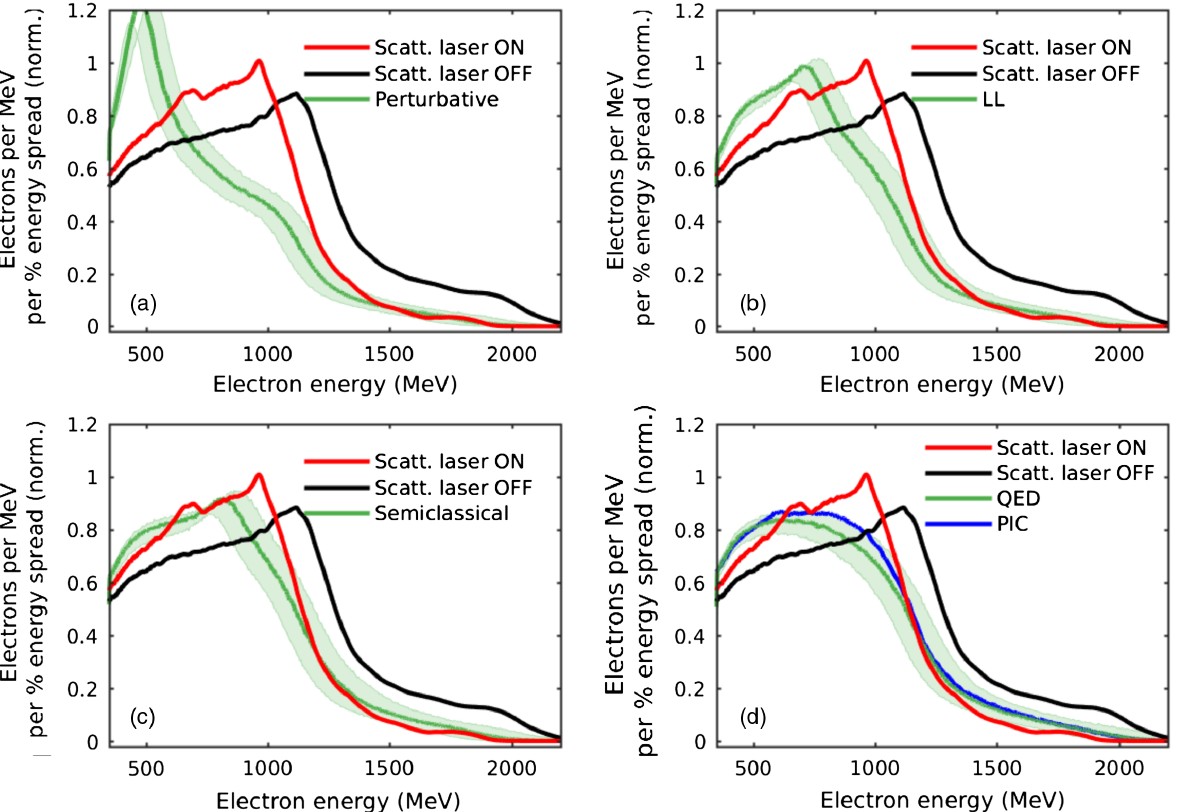
FIG. 4. Comparison of experimental results with theoretical models for the condition of best overlap. The experimentally measured electron spectrum without the scattering laser (black line) and the spectrum of scattered electrons (red line) and (a) the theoretical prediction assuming a model only based on the Lorentz force, (b) the Landau-Lifshitz equation, (c) a semiclassical model of radiation reaction, and (d) the quantum model of radiation reaction in a multiparticle code and in a PIC code (green and blue curves, respectively). In each frame, the uncertainties associated with the theoretical model arise from assuming the experimental uncertainty in the original electron spectrum, as arising from the energy uncertainty of the magnetic spectrometer, and shot-to-shot intensity fluctuations of the scattering laser. Details of the models used are discussed in the